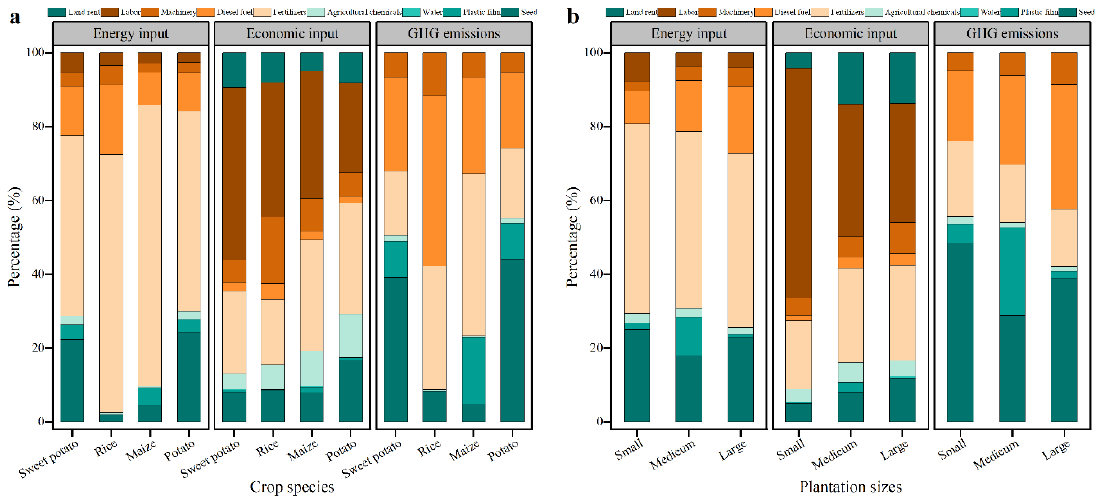
Figure 3. The percentage of each input source to the total energy inputs, economic inputs, and greenhouse gas (GHG) emissions under different crop species ( a ) and plantation sizes of sweet potato ( b ).